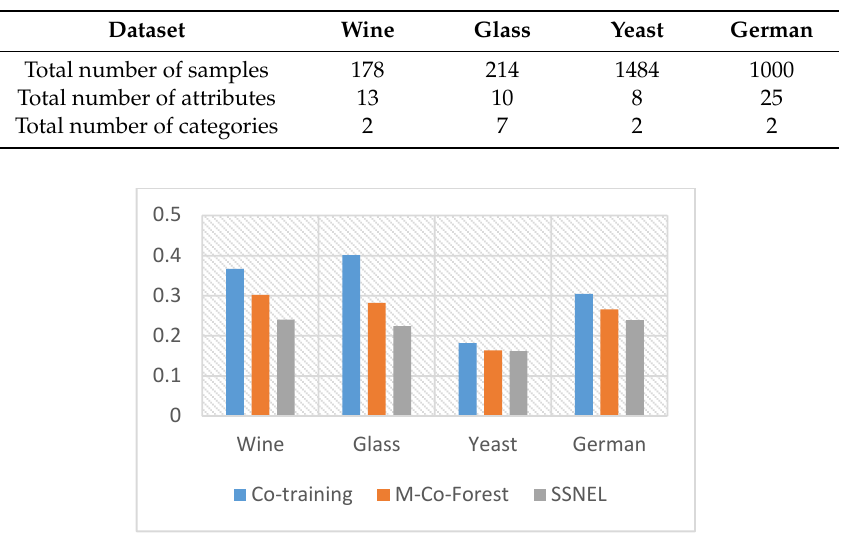
Figure 3. Comparison of test results on different UCI datasets.